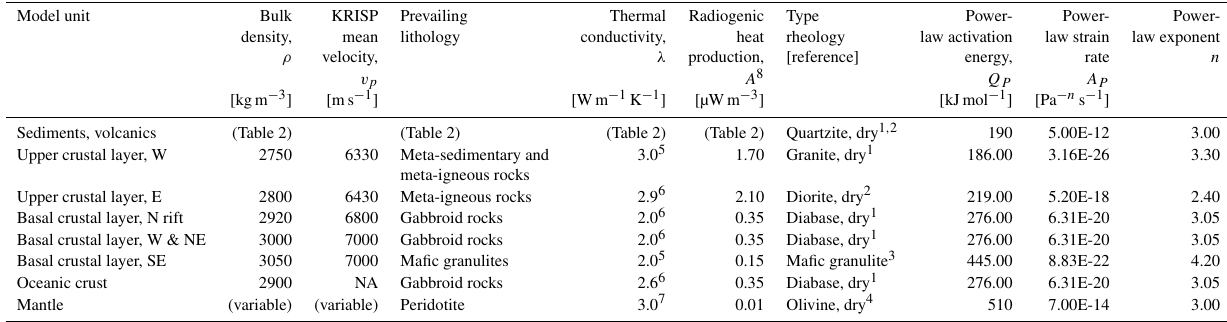
Table 4. Physical properties and lithologies of the model units. Model